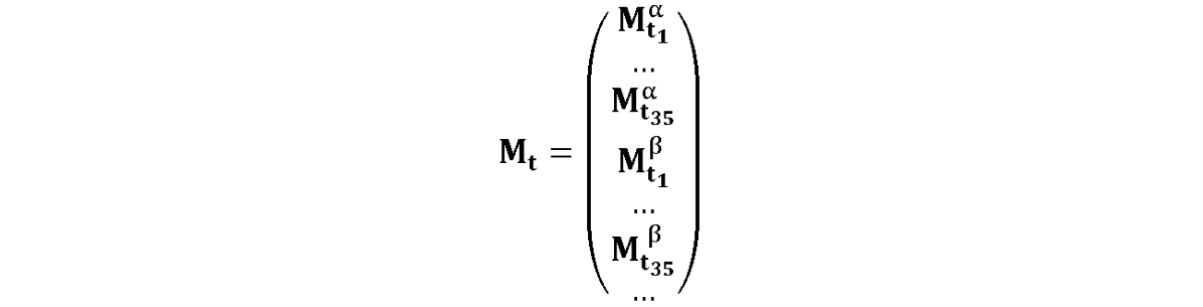
Figure 5. Sequential multiplex matrix of all subjects for all 35 images, where β indicates the 2nd participant, t n ≤ 43, and t n+1 =t n